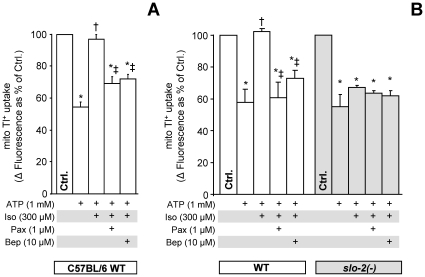
Isoflurane activation of mBK channel activity in mouse and C. elegans.
Mitochondrial Tl+ uptake was measured using a mitochondrial matrix loaded Tl+-sensitive fluorophore, as detailed in the methods section of Supporting Information S1. ATP was added to block the normally open mKATP channel. Characterization of mBK channel activity in isolated mitochondria from (A) WT (C57BL/6) mouse hearts and (B) WT (N2 Bristol) and slo-2(nf100) mutant C. elegans. Graph shows Δ fluorescence upon Tl+ addition to media. Where indicated, isoflurane (Iso) and the K+ channel inhibitors paxilline (Pax) and bepridil (Bep) were present as listed below the x-axis. Data are means ± SEM, N≥3 (N = independent mitochondria preparations). *p<0.05 vs. ctrl, †p<0.05 vs. ATP, ‡p<0.05 vs. ATP+Iso.